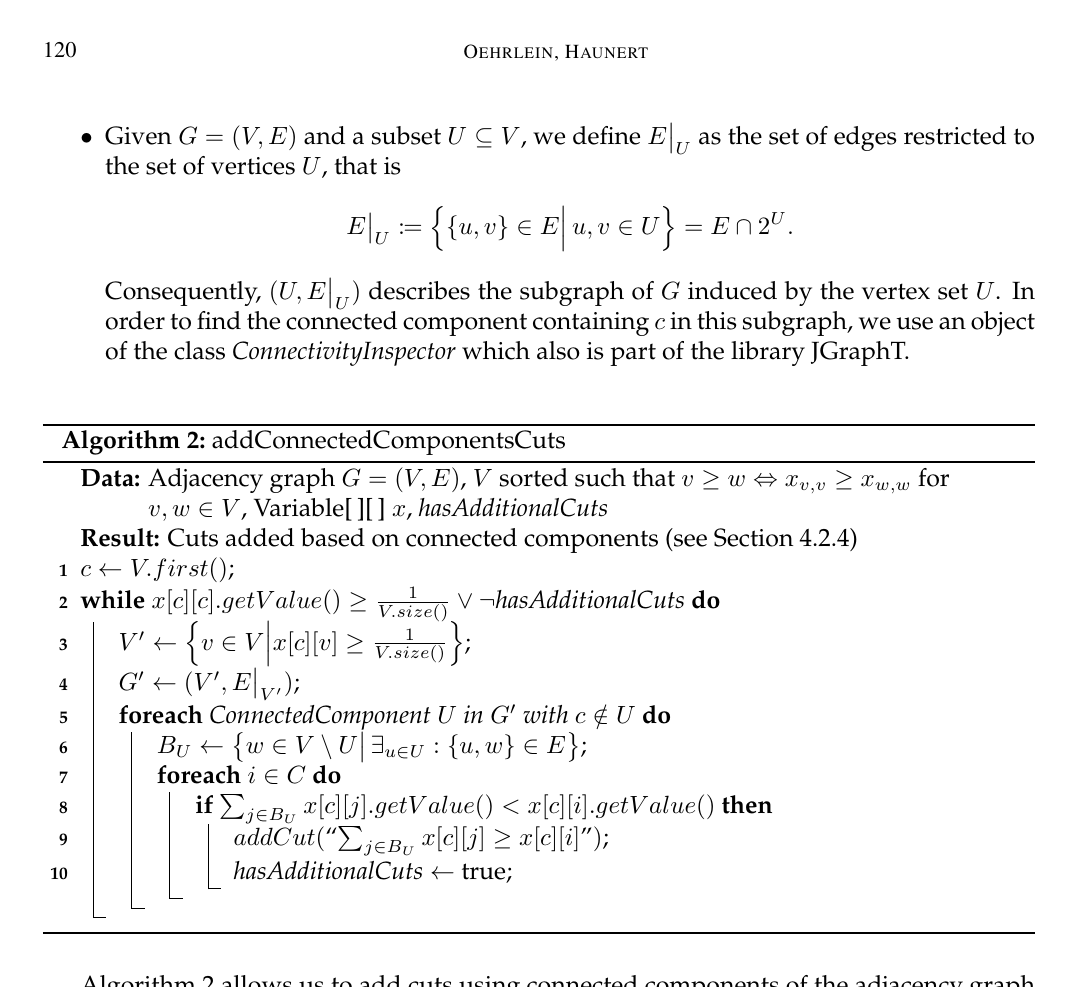
Algorithm 2 allows us to add cuts using connected components of the adjacency